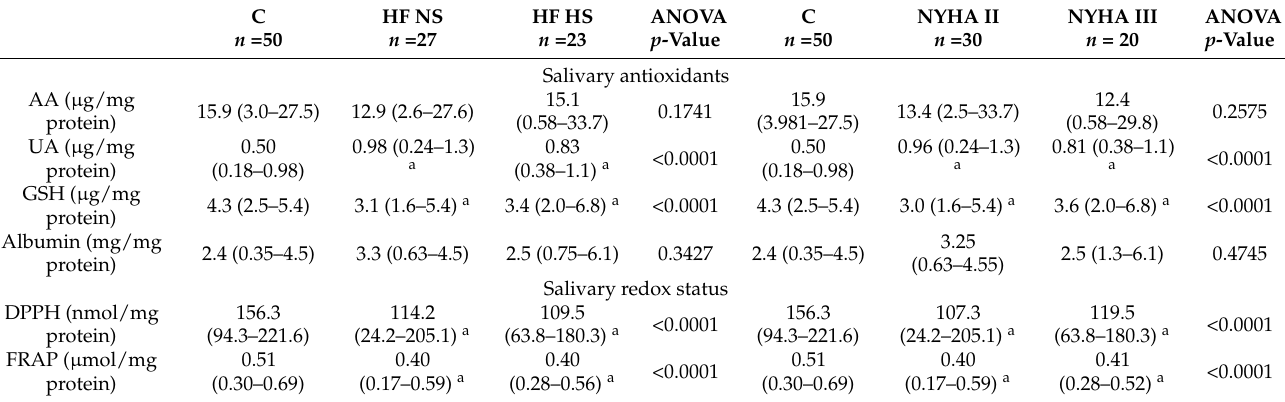
Table 3. Plasma and erythrocyte redox biomarkers in HF patients and the control